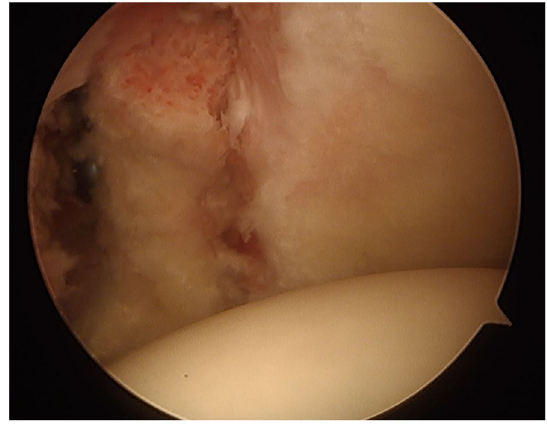
Fig. 2 Intraoperative imaging of a Latarjet procedure with the coracoid graft accurate positioned